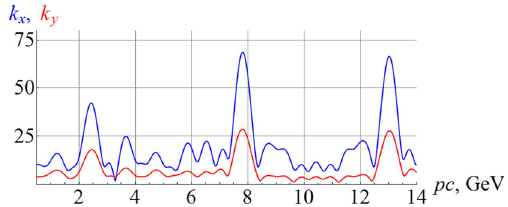
Fig. 7 Navigator tune enhancement coefficients k x and k y as a func- tion of the longitudinal coordinate in the NICA collider for protons at γ G = 6 . 5. The black and green rectangles indicate quadrupoles and arc dipoles, respectively. The origin of the coordinate frame corresponds to an interaction point F y ( z ) = 0 and the radial response function has zero vertical component F x , 2 ( z ) = 0. This allows for use of only radial dipoles to control the spin in the collider’s plane (2D-SN).